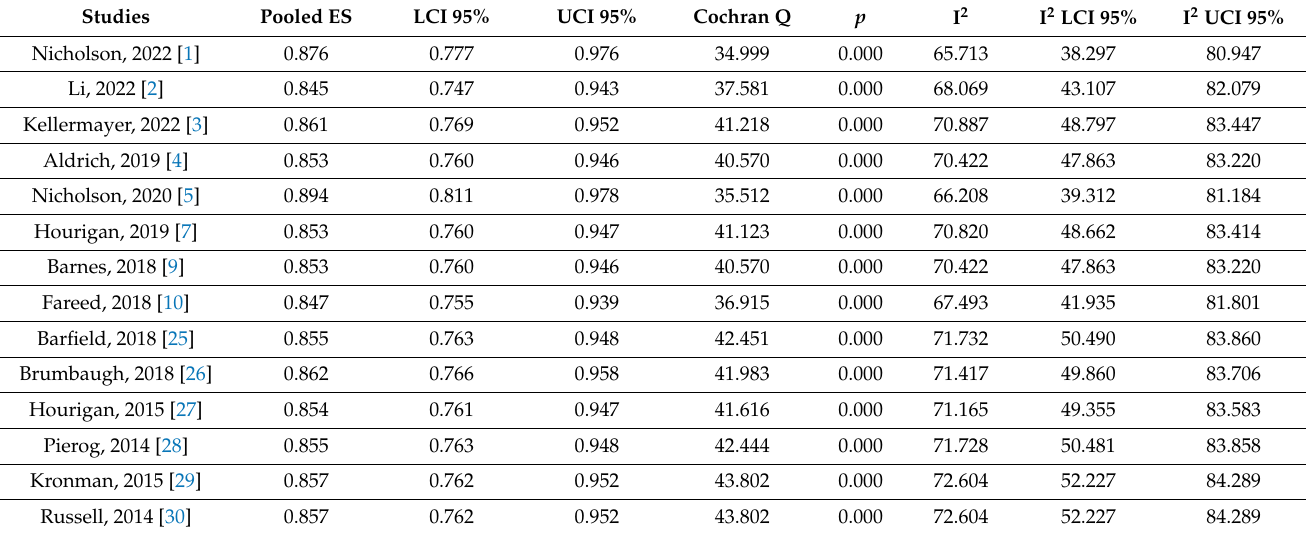
Table 8. Outputs of sensitivity analysis ( n =